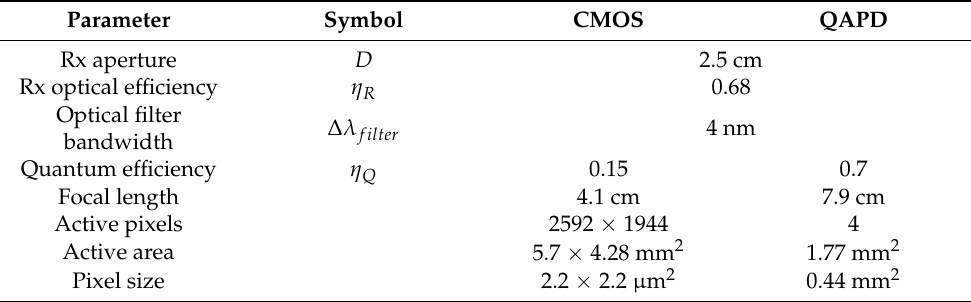
Table 1. Receiver parameters used in the numerical